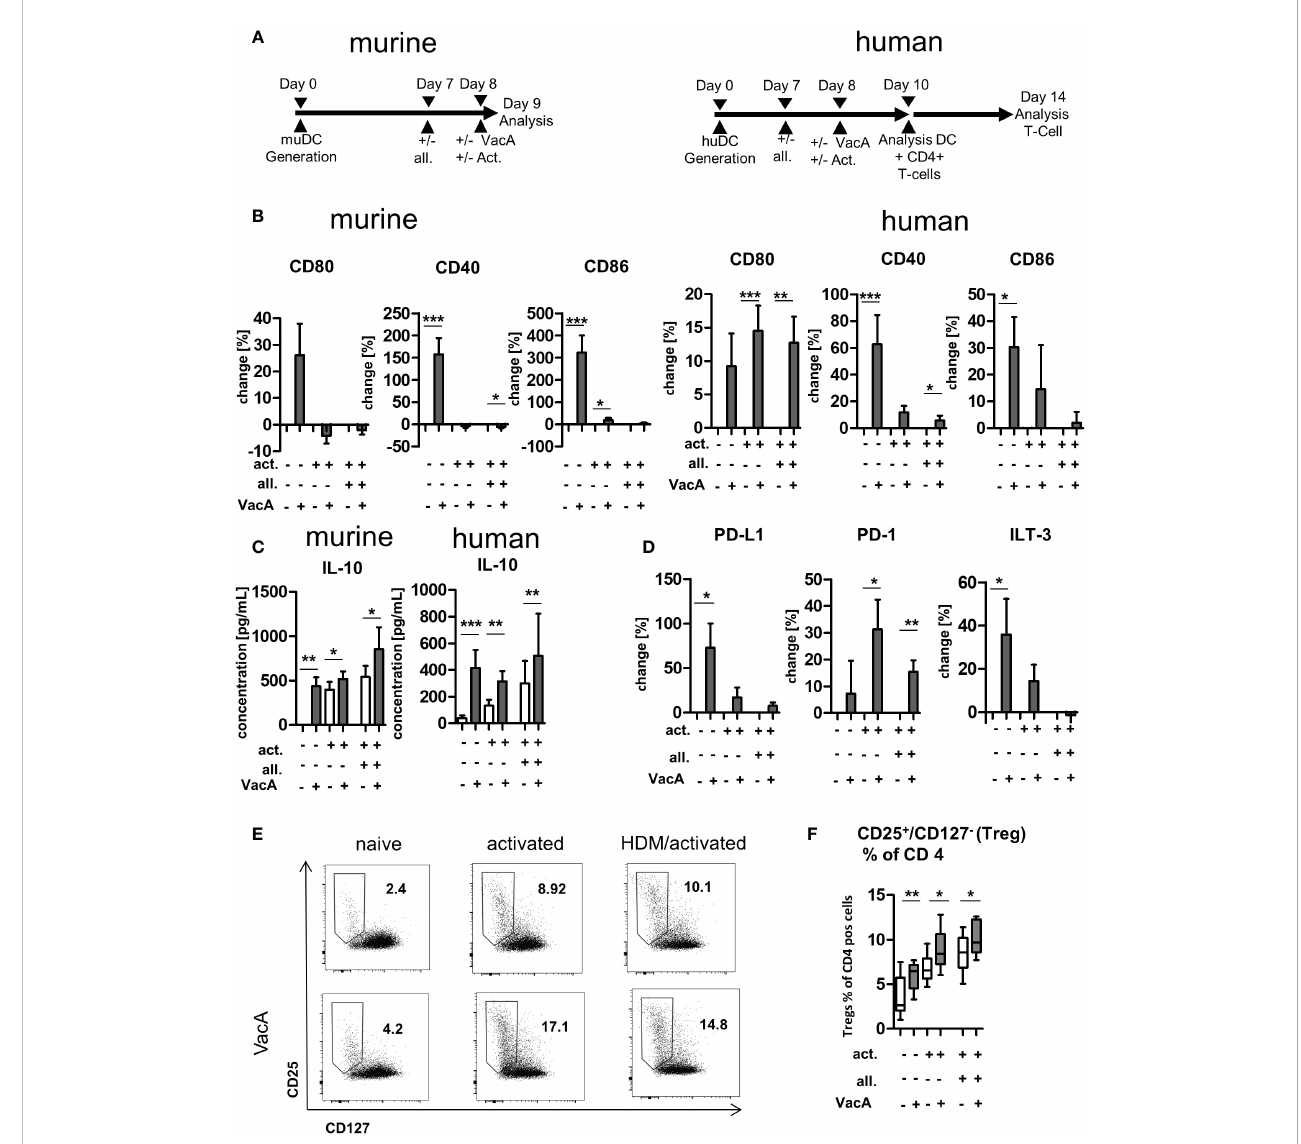
FIGURE 5 VacA modulates expression of stimulatory and inhibitory co-receptors and cytokines in murine and human dendritic cells (DC) and induces humanregulatory T cells (Tregs). (A) Treatment scheme: murine bone marrow DC (BMDC)/human DC: after 7 days of differentiation DC were treated +/-allergen (all), then DC activation (act.) was performed and treatment with VacA was given. Cultivation of human DC with autologous T cells wasperformed from day 10 – 14. (B) Change in expression of the indicated surface marker after treatment with VacA versus naïve, activated, or activated andallergen-supplemented murine and human DC. (C) Supernatant concentrations of interleukin (IL)-10 in naïve, activated, and activated and allergensupplementedmurine and human DC cultures with or without VacA. (D) Change in expression of the indicated surface marker with inhibitory capacityversus VacA treatment on the surface of naïve, activated, or activated and allergen-supplemented human DC (murine, n=14; human, n=10). AutologousT cells were cultured with the differentially activated and VacA-treated DC and the proportion of regulatory T cells was then examined. (E) Dot plots:regulatory T cells were identi fi ed by gating CD25+/CD127- cells within the population of CD4+/CD3+ T helper cells. Dot plots show representativeexamples for CD25/CD127 staining of naïve, activated, and activated and allergen-supplemented human DC/T cell cultures with or without VacAtreatment. Gate and proportion of Tregs is highlighted. (F) Percentage of Tregs within the CD4+ T cell population. VacA treatment signi fi cantly increasedTregs in all analyzed culture conditions (n=10). Wilcoxon signed rank test: *p<0.05, **p<0.01,